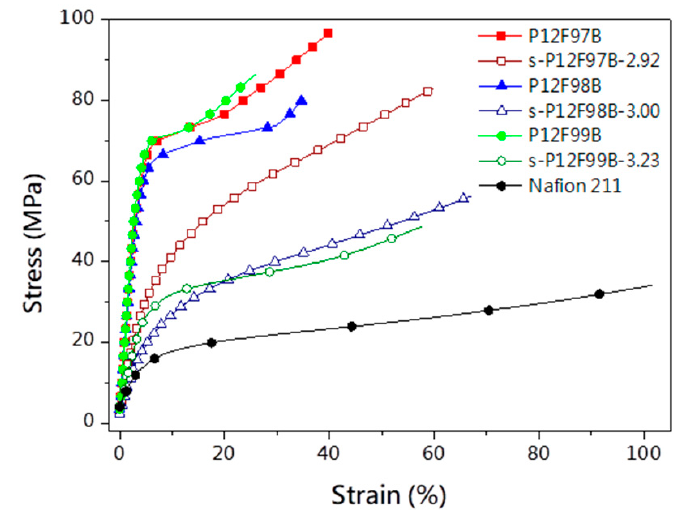
Figure 3. Stress–strain curves of MEAs at 25 °C and 40% RH.